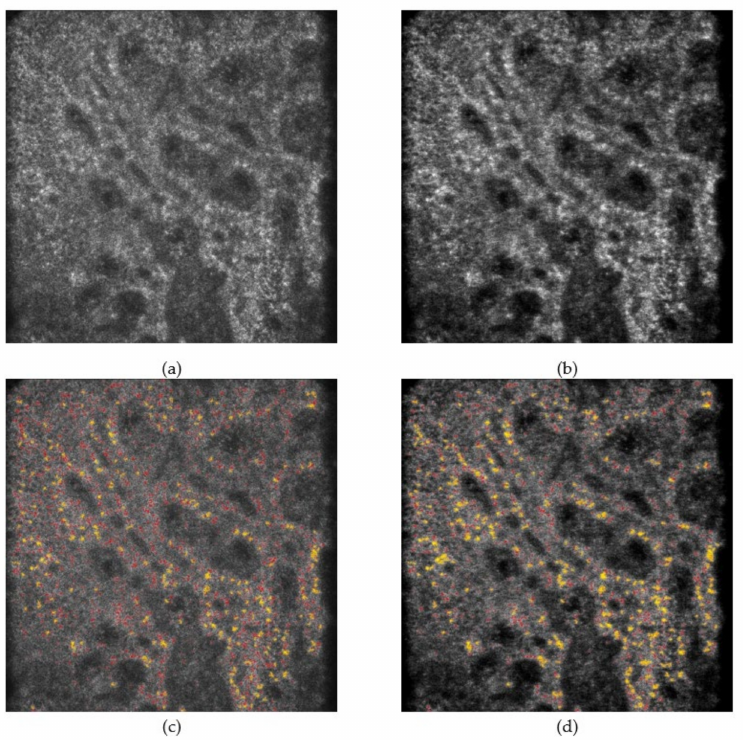
Figure 7. The performance comparison of CADe with and without SC-DnCNN on the perilesional skin images. ( a , b ) are the input image and the denoised image, respectively, while ( c , d ) are the output results when superimposing the detected melanin on those images (grain melanin is represented in red, and confetti melanin is represented in yellow), respectively. The field of view is 475 × 476 µ